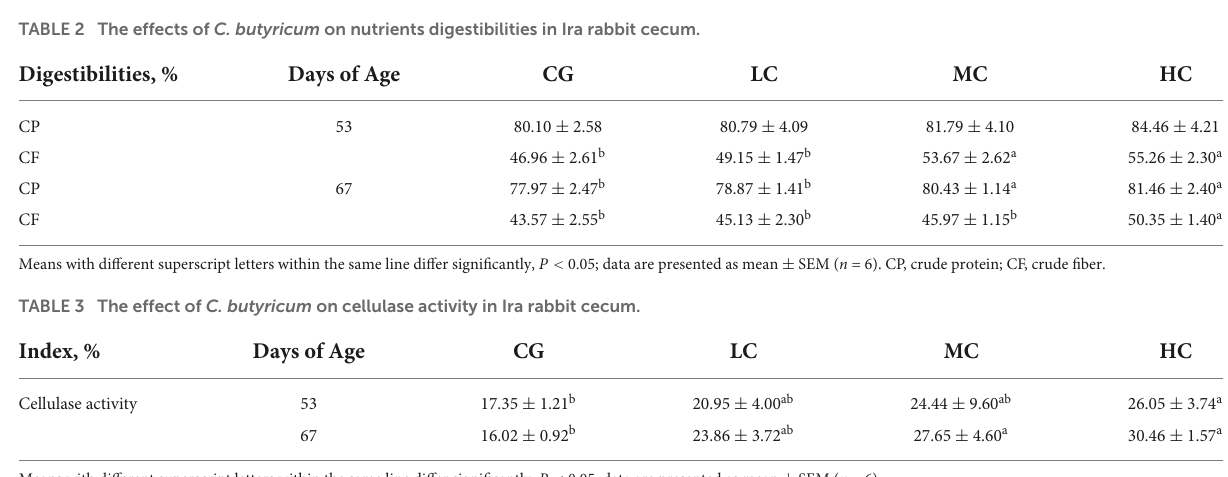
analysis, there were correlations between BW, ADG, and different metabolites. From Figure 7A , at